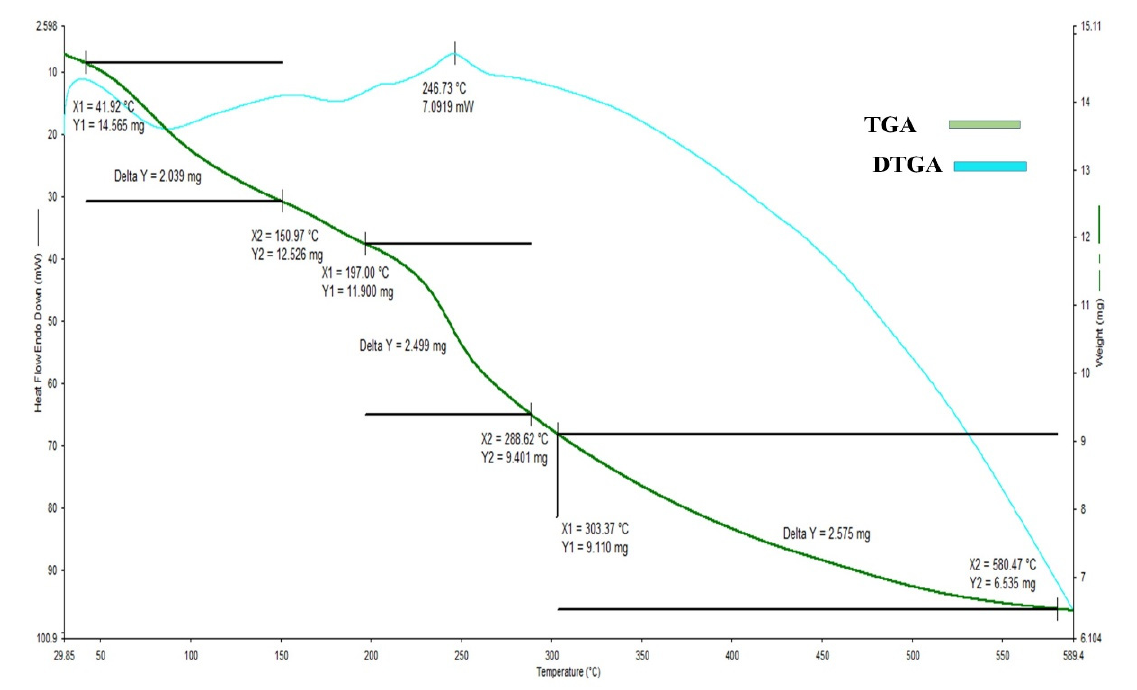
Figure 3. Thernogravimetric and different thermogravimetric analysis of fucoidan from the brown seaweed Sargassum ilicifollium .